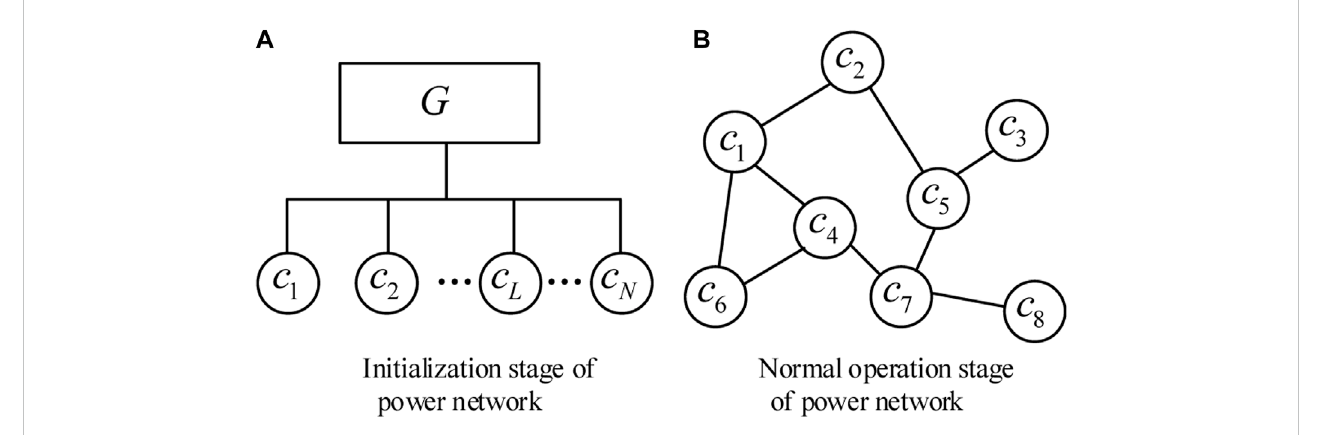
FIGURE 3 (A) Initialization stage and (B) normal operation stage of power